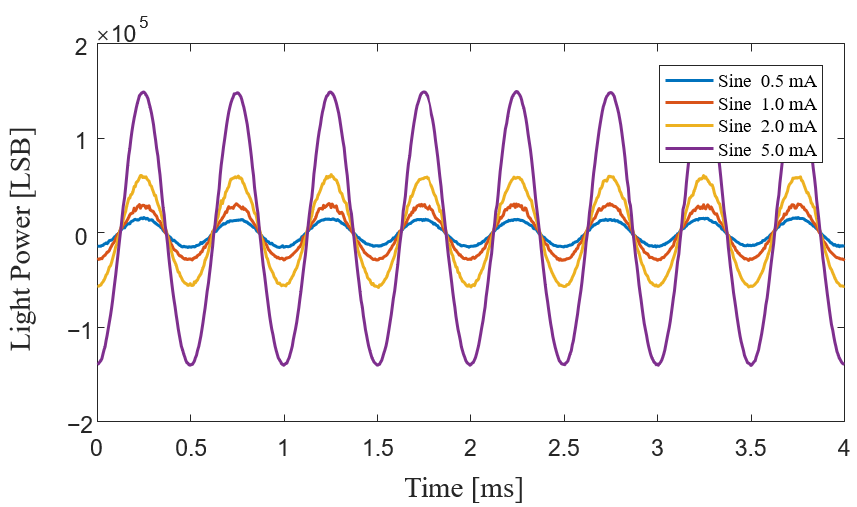
Figure 6. Experimental demodulated SLD power signals while the driving current was a sine wave with a bias of 100 mA and different amplitudes of 0.5 mA, 1.0 mA, 2.0 mA, and 5.0 mA.